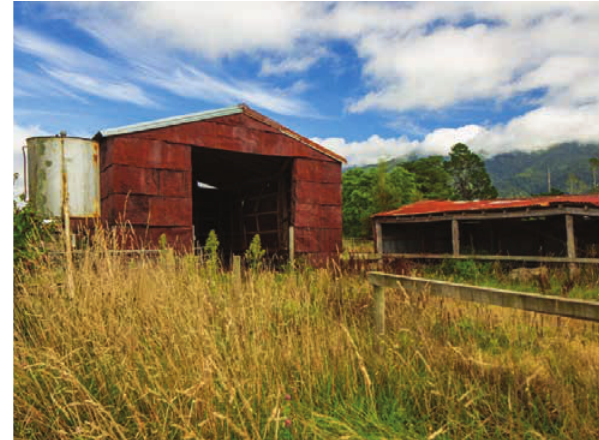
Figure 2: An unused historic farm building crumbling in situ, Central Otago, New Zealand. Image provided by Author (Mike Mackay)